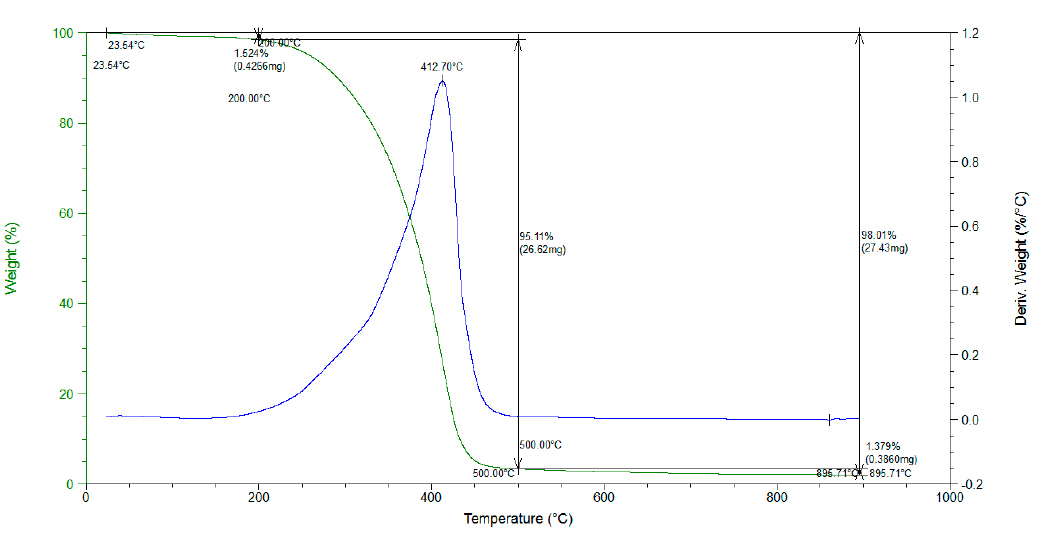
Figure 9. TGA and DTG curves of the product.